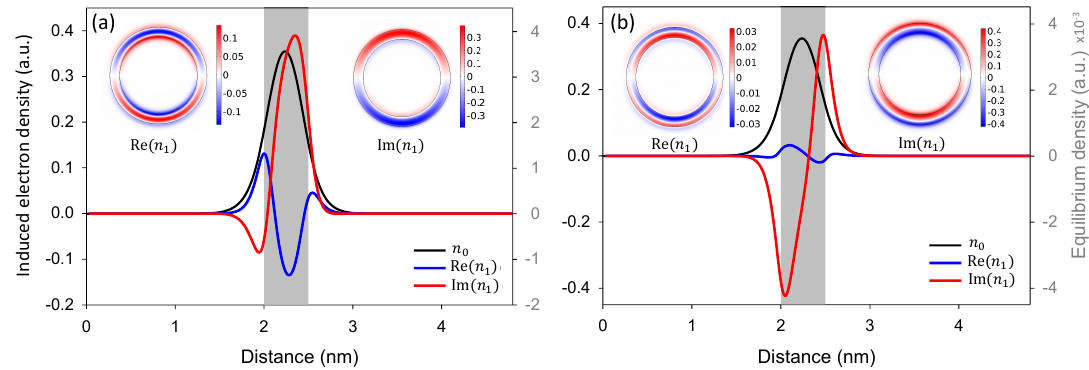
Figure 3. Induced electron density n 1 and ground-state density n 0 for Na nanoshell with t s = 0.5 nm at ( a ) low-energy mode (LEM) and ( b ) high-energy mode (HEM). The insets show the map plots for real and imaginary part of the induced density.